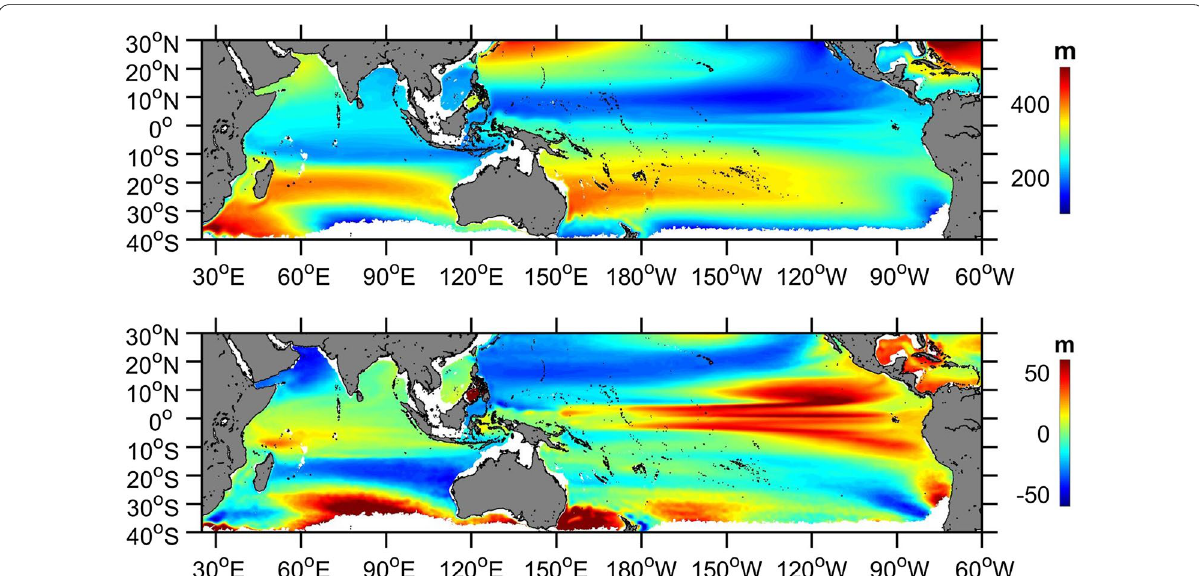
Fig. 4 14 °C isotherm depth over the Indo-Pacific Ocean. (top panel) Average 14 °C isotherm depth over the Indo-Pacific Ocean during 2006–2026, and (lower panel) average 14 °C isotherm depth difference between 2081 and 2101 and 2006–2026 in an OFAM3 simulation forced by RCP8.5 climate change forcing. A mean difference of 40.8 m has been removed from the lower